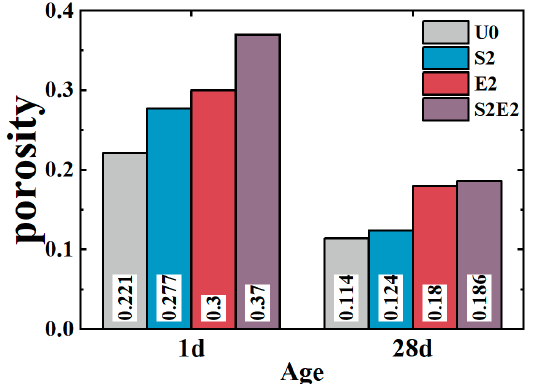
Figure 7. Total porosity of UHPC matrix.